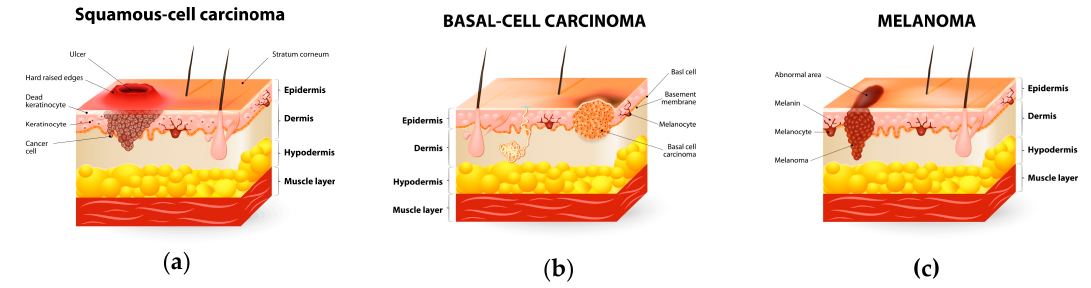
Figure 4. The illustrations of the types of skin cancer, namely: ( a ) Squamous cell carcinoma; ( b ) Basal cell cancer and ( c ) Melanoma.